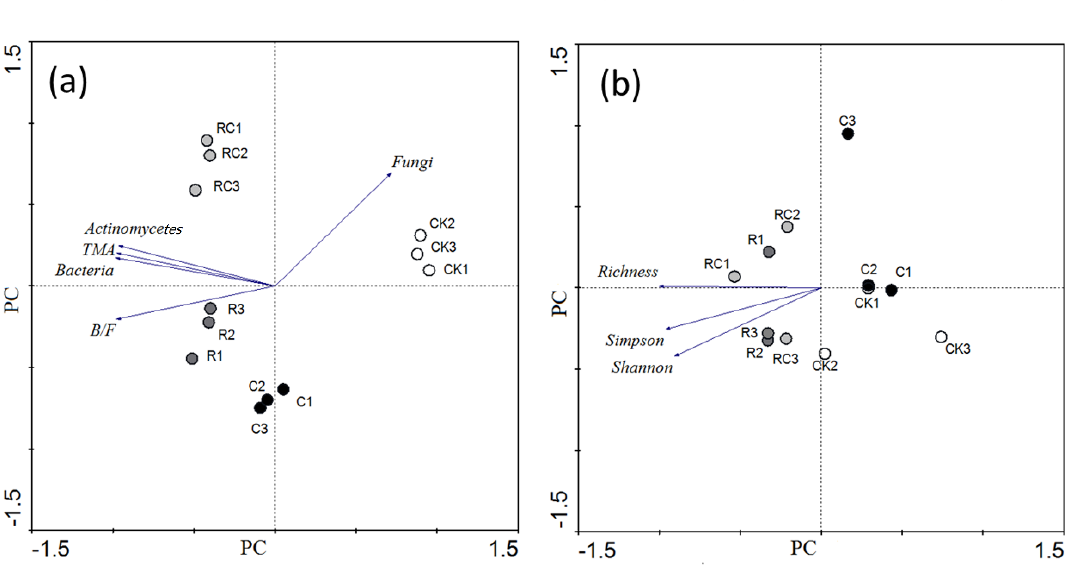
Table 3. Effects of rice straw and biochar on soil microbial diversity.